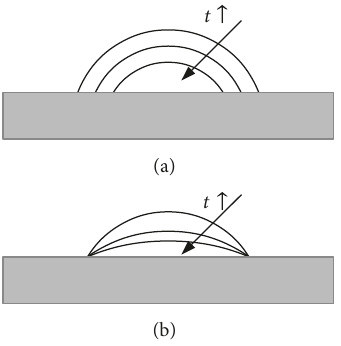
Figure 3: (a) Constant Contact Angle (CCA) mode and (b) Constant Contact Radius (CCR)